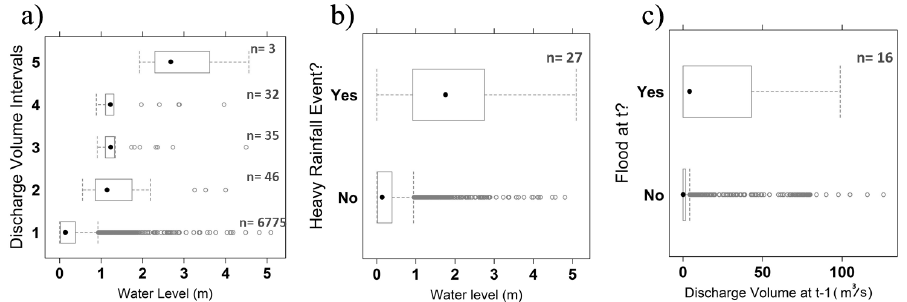
Figure 6. (a) Relation between discharge intervals and the daily maximum water height (m) measured at Cártama. Range intervals (m 3 s − 1 ): [0, 25.2] (25.2, 50.4] (50.4, 75.6] (75.6, 101] (101, 126]. (b) Ocurrence of heavy rainfall events related with the water level. (c) Ocurrence of floods related with time-lagged ( t -1) discharge values